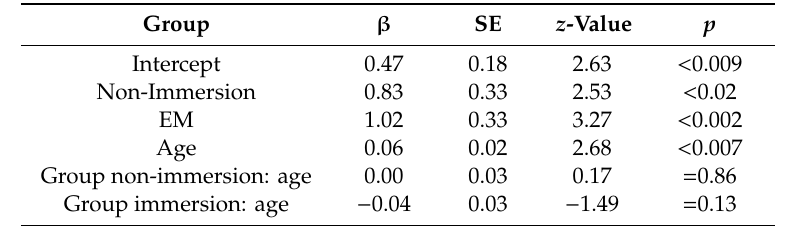
Figure 2. Proportion of overt responses in English as a function of age (centered) and group. Table 3. Coefficients in English.